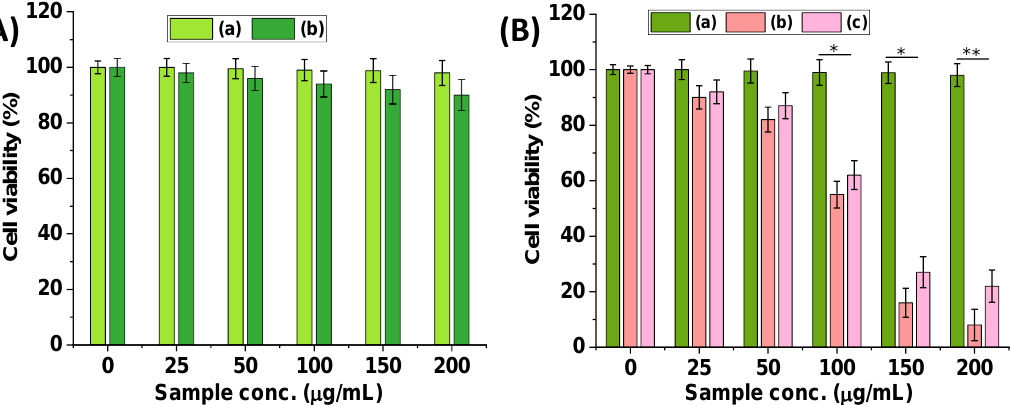
Figure 7. ( A ) In vitro biocompatibility of (a) control MDA-MB-231 cells; (b) MS@PNIPAm-PAAm NPs without Dox loading, at different concentrations. ( B ) In vitro cytotoxicity of (a) control MDA-MB-231 cells, (b) MS@Dox/PNIPAm-PAAm NPs, and (c) a pure Dox sample, respectively, at different sample concentrations. Statistical significance to the cell toxicity with different samples (*, significant p < 0.05; **, highly significant p < 0.01).